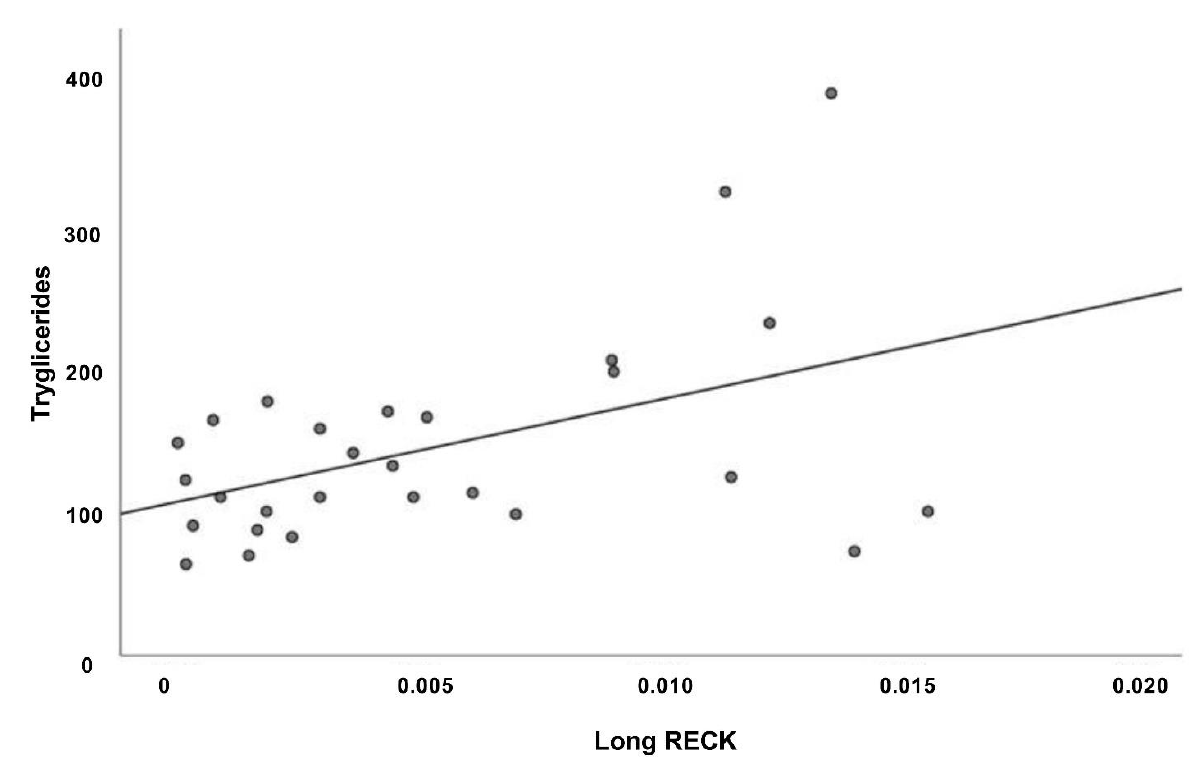
Figure 7. Correlation analysis of Long RECK splice variant in CTR group ( n = 19). Scatter plots depict the relationship among Long RECK and ( A ) HDL value ( R 2 = 0.297, p < 0.05, Pearson r = 0.545); ( B ) Triglycerides levels ( R 2 = 0.206, p < 0.05, Pearson r = −0.460).